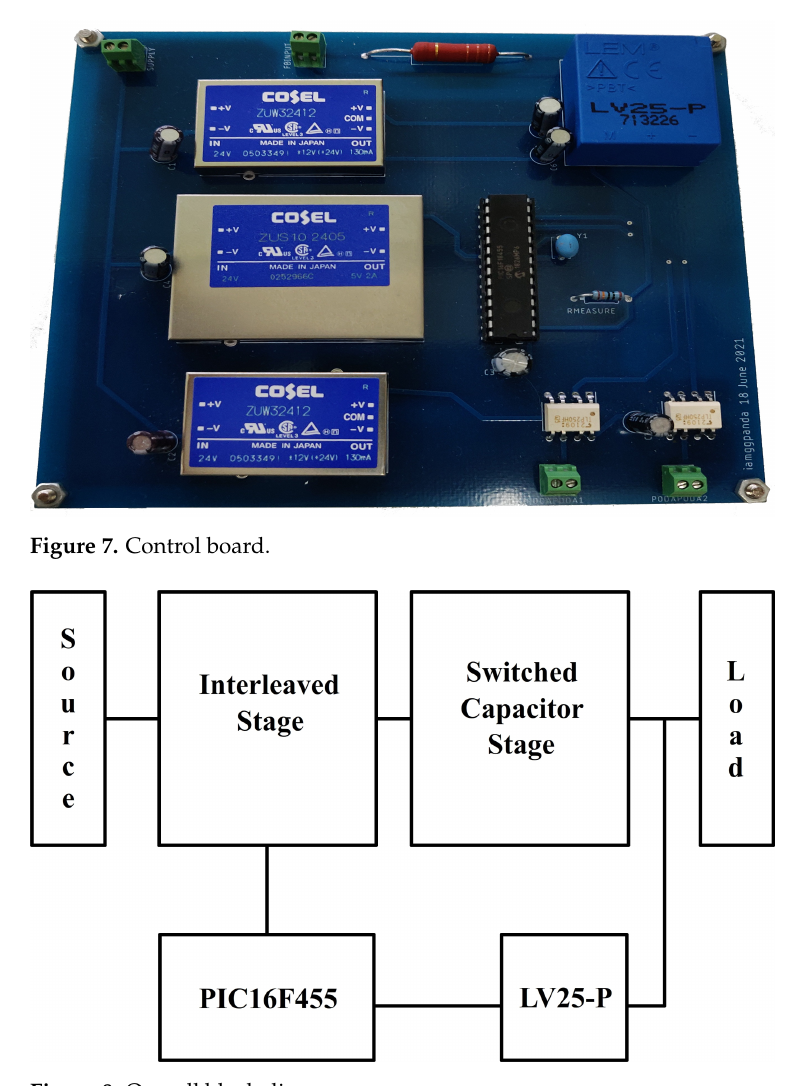
Figure 8. Overall block